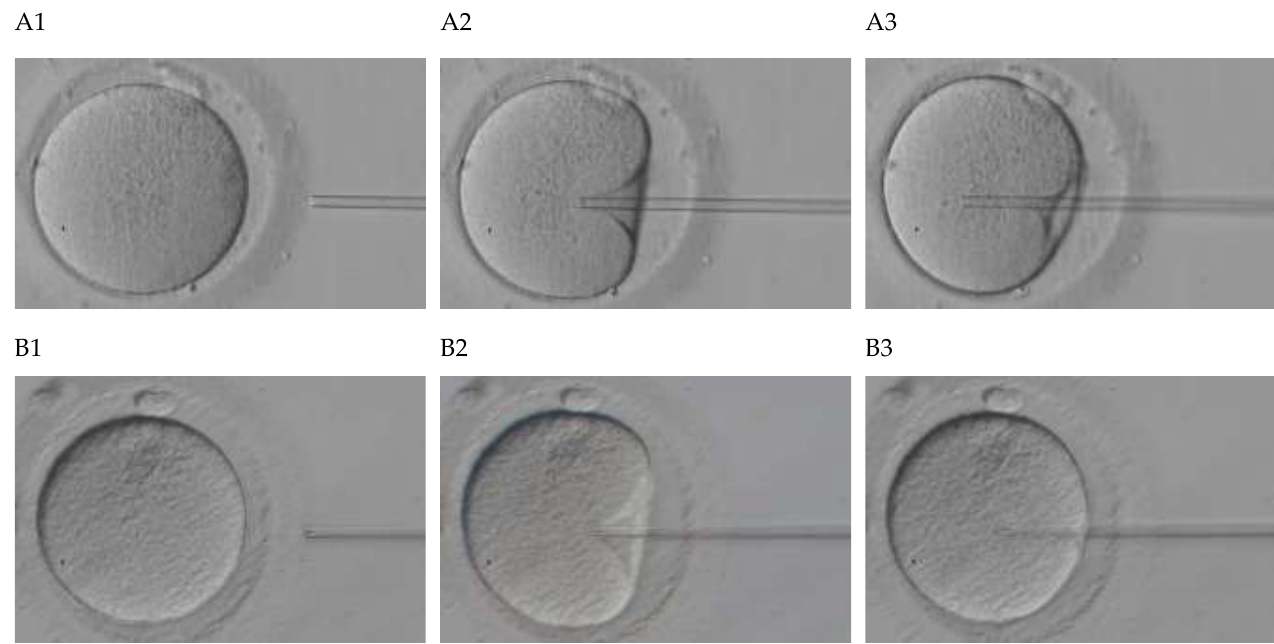
Figure 1. Oocyte under Piezo-ICSI. ( A ) Nonruptured oocyte. ( B ) Ruptured oocyte. A1, injection pipette directed toward the center of an oocyte. A2, injection pipette of A1 was inserted more deeply. A3, the injection pipette of A2 was inserted more deeply, and it smoothly penetrated the oocyte cytoplasmic membrane without rupture. B1, an injection pipette directed toward the center of an oocyte. B2, the injection pipette of B1 was inserted more deeply. B3, the injection pipette of B2 was inserted more deeply, and it did not smoothly penetrate the oocyte cytoplasmic membrane with rupture. All images for A1-B3 are of 744 pixels width and 453 pixels height.